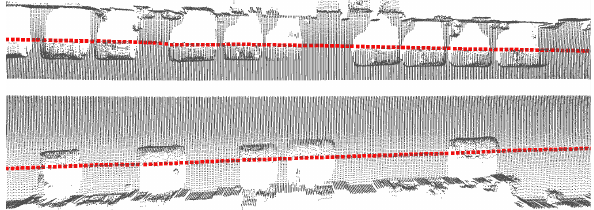
Figure 8: Result of the prediction/estimation road side detection model in two linear parts with many occlusions (red